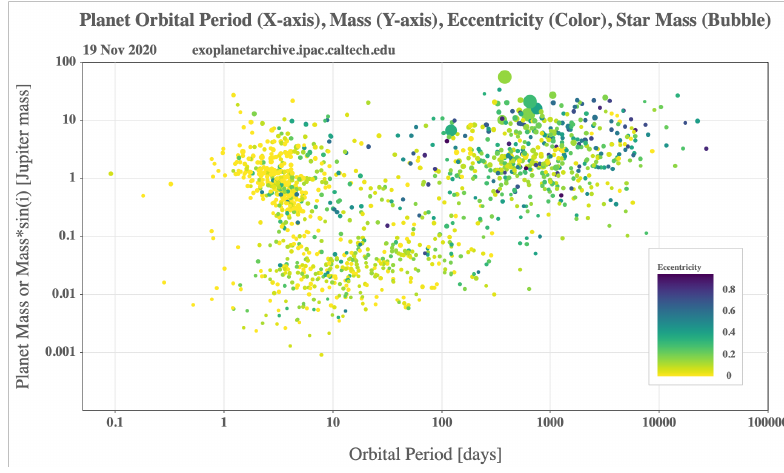
Figure 4. Orbital characteristics of exoplanets in NASA Exoplanet Archive [53]. Another peculiarity of many exoplanets is their high